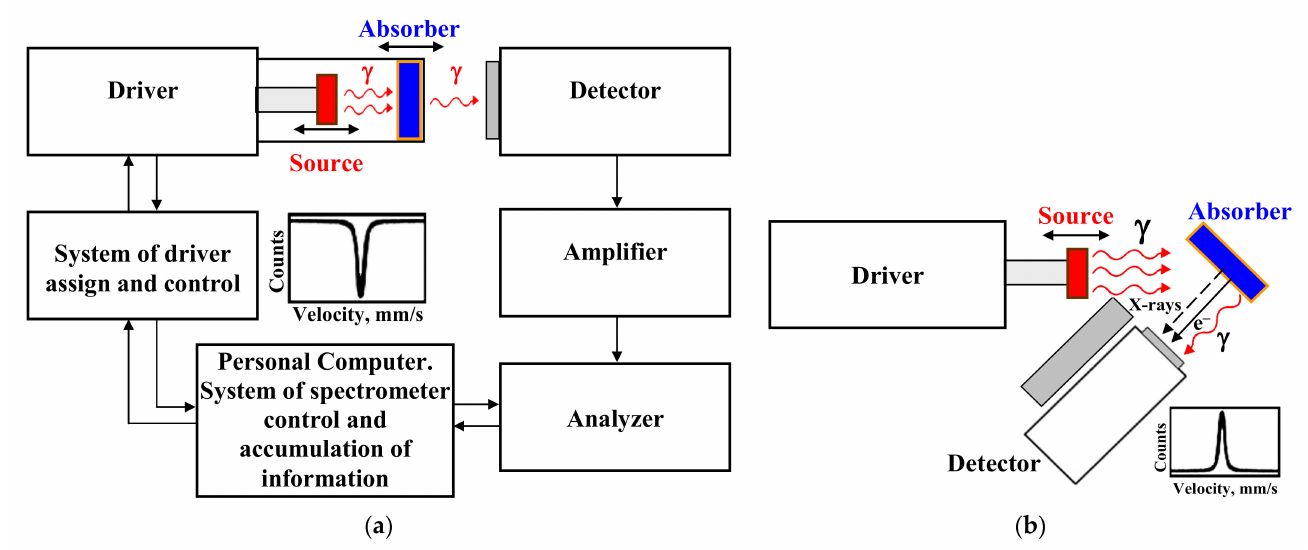
Figure A10. Simple block-scheme of Mössbauer spectrometer with moving source or absorber in transmission geometry ( a ) and a part of block-scheme of Mössbauer spectrometer with moving source in backscattering geometry ( b